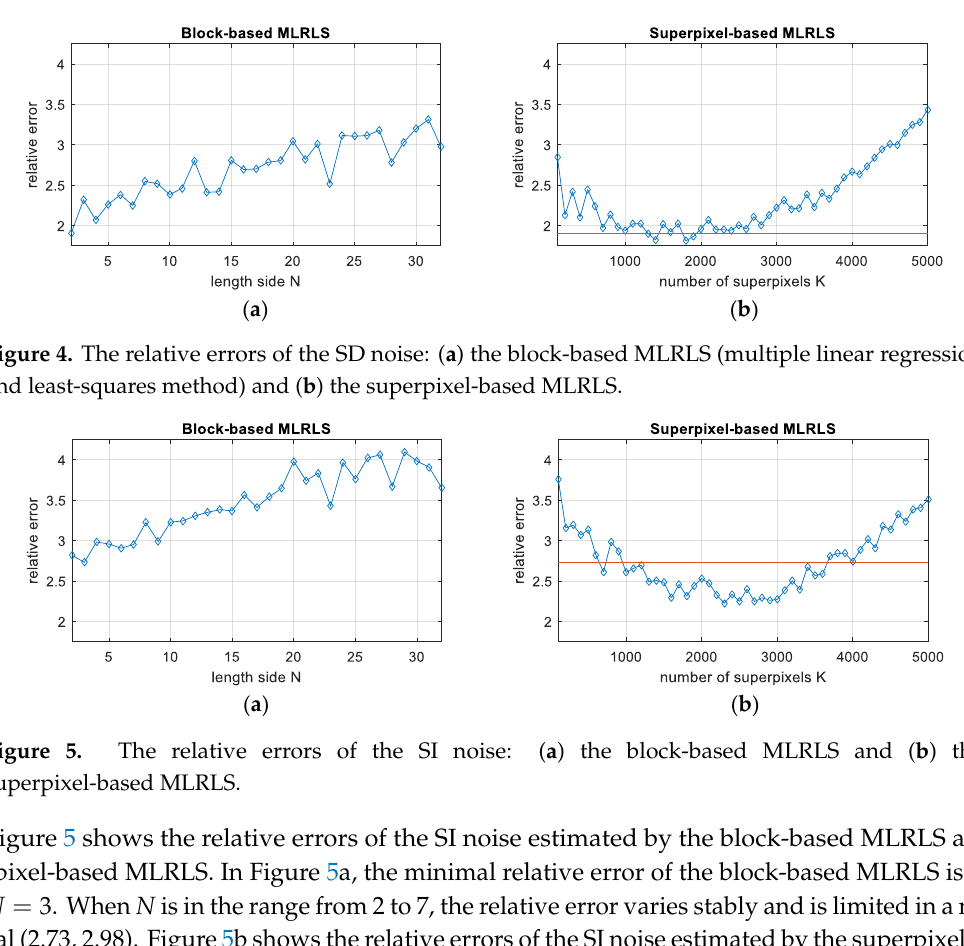
Figure 6. The relative errors of the overall concerned: (<a>) the block-based MLRLS and (<b>) the superpixel-based MLRLS.